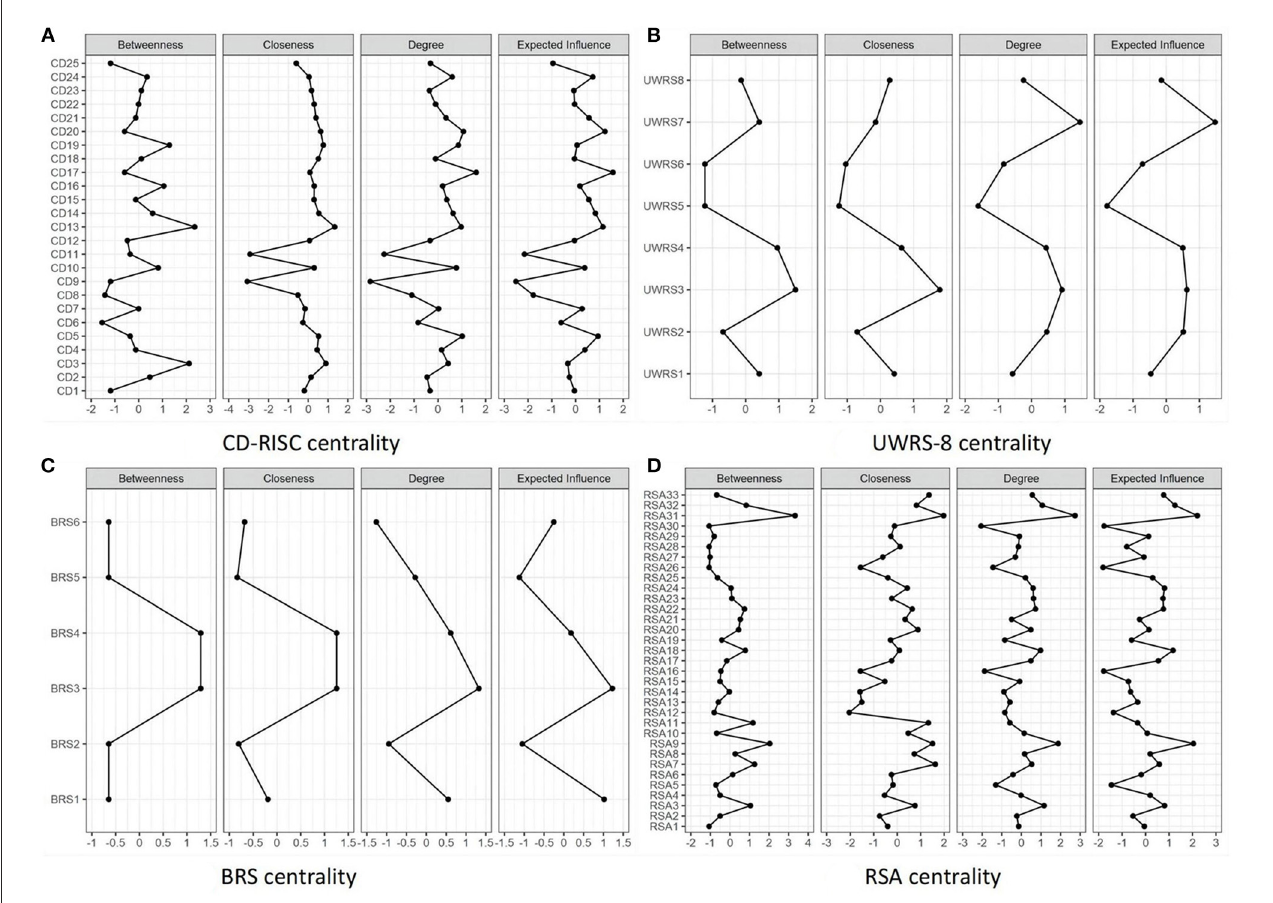
FIGURE2 Centrality network of resilience as measured by four single scales. (A) CD-RISC centrality. (B) UWRS-8 centrality. (C) BRS centrality. (D) RSA